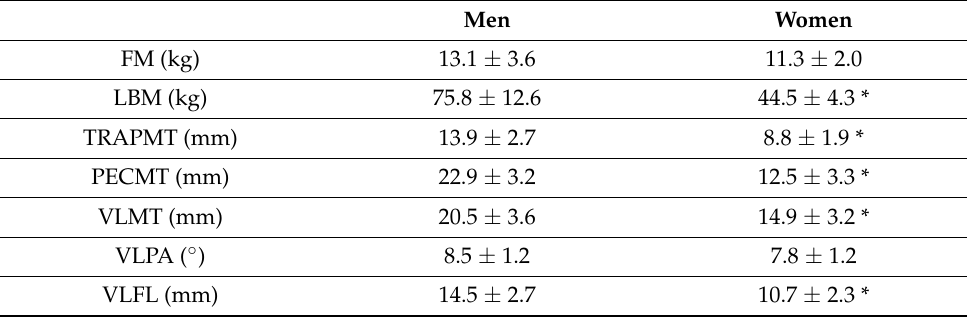
Table 1. Mean ± SD anthropometric and muscle architecture values in men and women. FM = fat mass; LBM = lean body mass; TRAPMT = muscle thickness of trapezius muscle; PECMT = muscle thickness of pectoralis muscle; VLMT = muscle thickness of vastus lateralis; VLPA = pennation angle of vastus lateralis; VLFL = fascicle length of vastus lateralis. * denotes a significant ( p ≤ 0.05) differences between